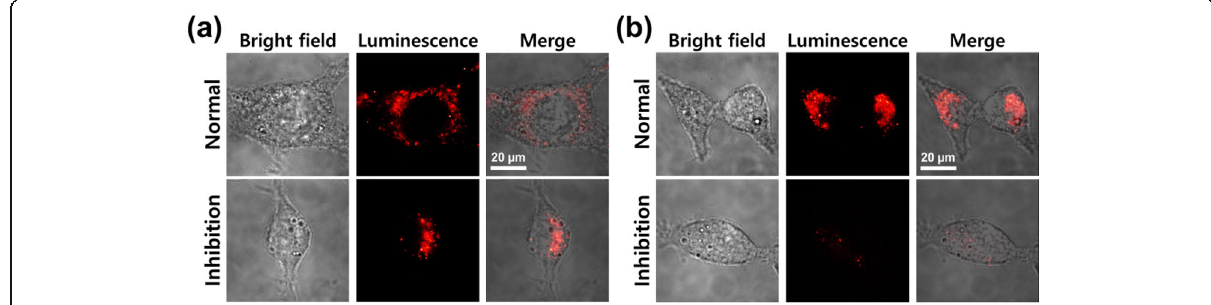
Fig. 6 Confocal microscopic imaging of CT26 mucin cells incubated with a Fe 3 O 4 -Au NPs and b PEG-nanobody-tagged NPs for 1 h at 37 °C in 5% CO 2 incubator, before and after dynasore inhibition (1